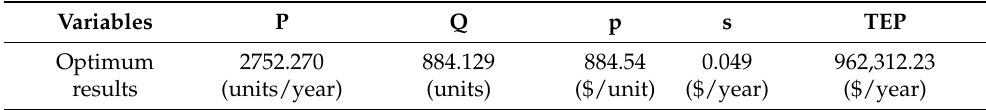
Table 2. Optimum results from Example